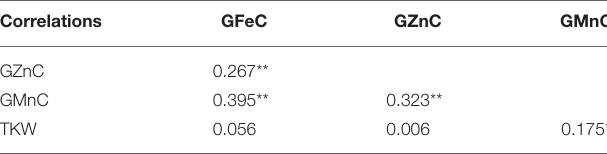
Frontiers in Plant Science |